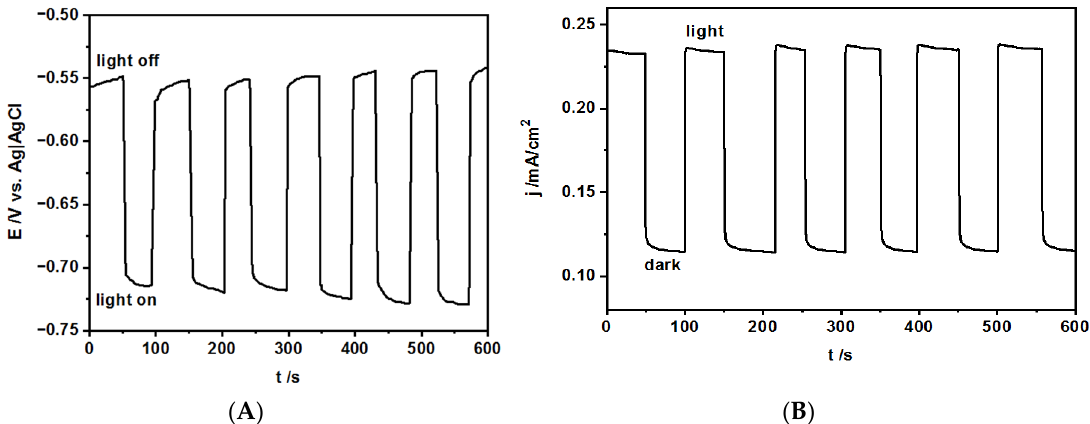
Figure 6. ( A ) Open circuit potential of the CdS nanoparticles film deposited onto glassy carbon electrode substrate, recorded in the 0.1 M polysulfides solution vs. Ag,AgCl / 3M KCl aq reference electrode; ( B ) photocurrent density of the CdS nanoparticles film deposited onto glassy carbon electrode substrate, recorded in the 0.1 M polysulfides solution and applied potential of − 0.5 V vs. Ag,AgCl / 3M KCl aq reference